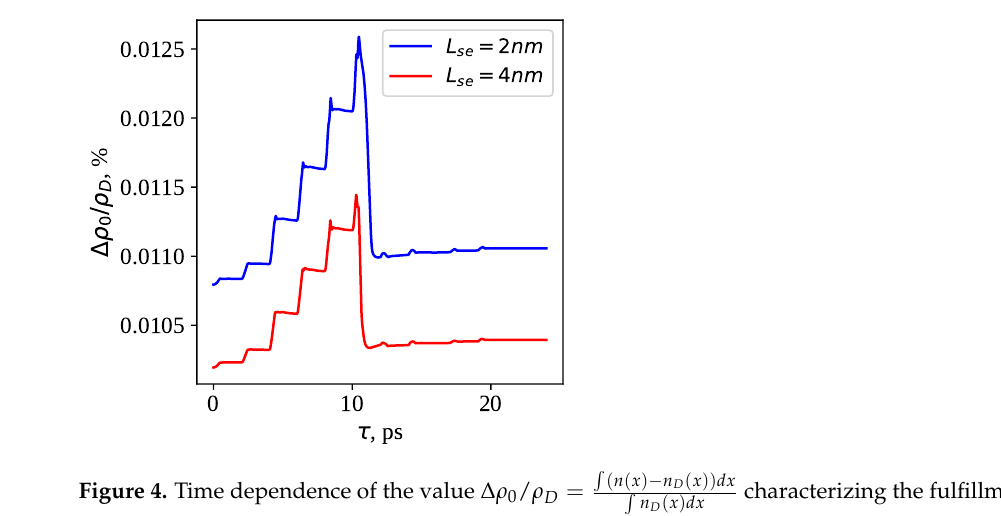
Figure 4. Time dependence of the value ∆ ρ 0 / ρ D = the electroneutrality condition.